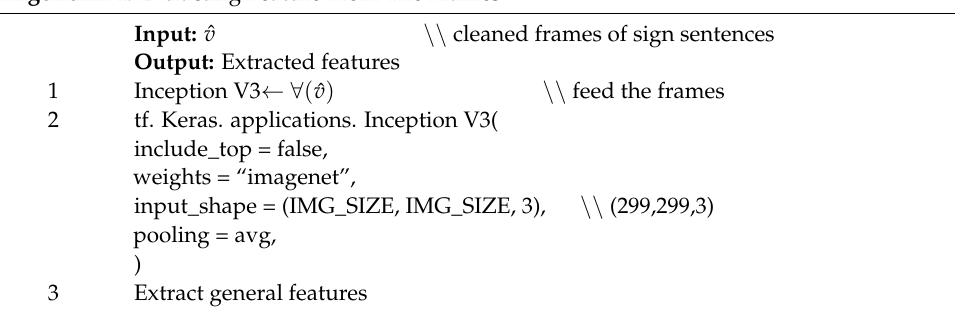
Algorithm 4: Extracting Feature From The Frames